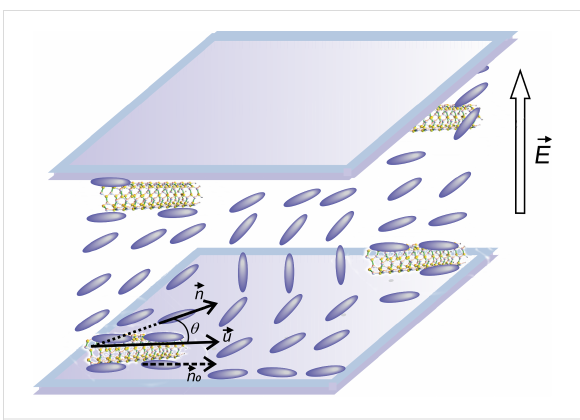
Figure 2: Carbon nanotubes in a liquid crystal cell exposed to an elec- tric field.